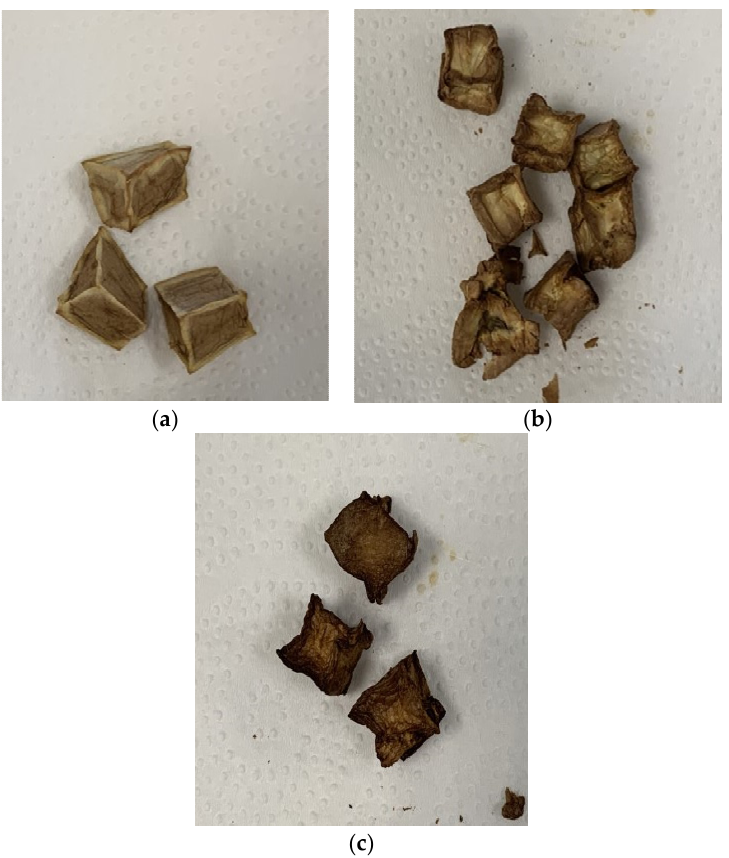
Figure 1. Eggplant samples air-fried at 150 ◦ C for 5 min ( a ), 15 min ( b ), and 25 min ( c